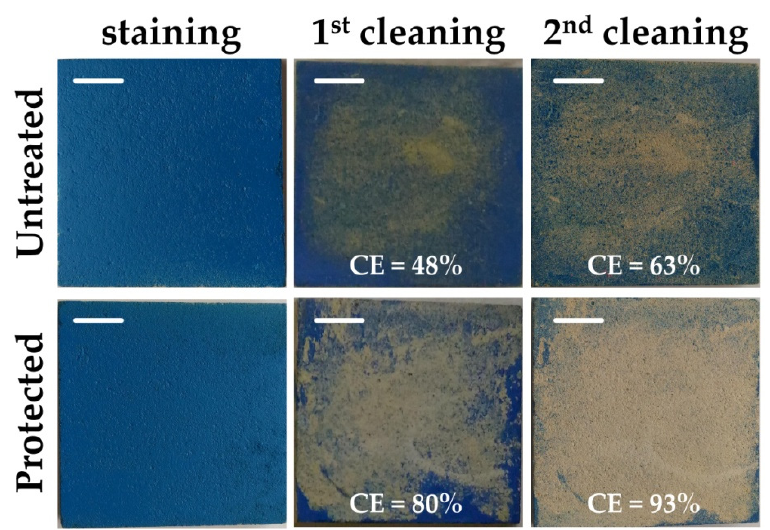
Figure 6. Untreated and protected stone samples after the staining and after the cleaning actions; the CE values, as defined in Equation (6), are reported. Each scale bar indicates 1 cm.